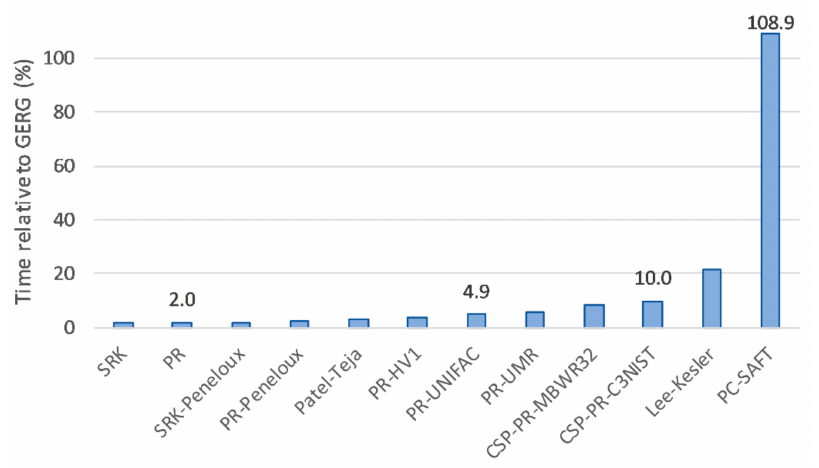
Figure 6. Relative computational time compared to the reference EOS. GERG =